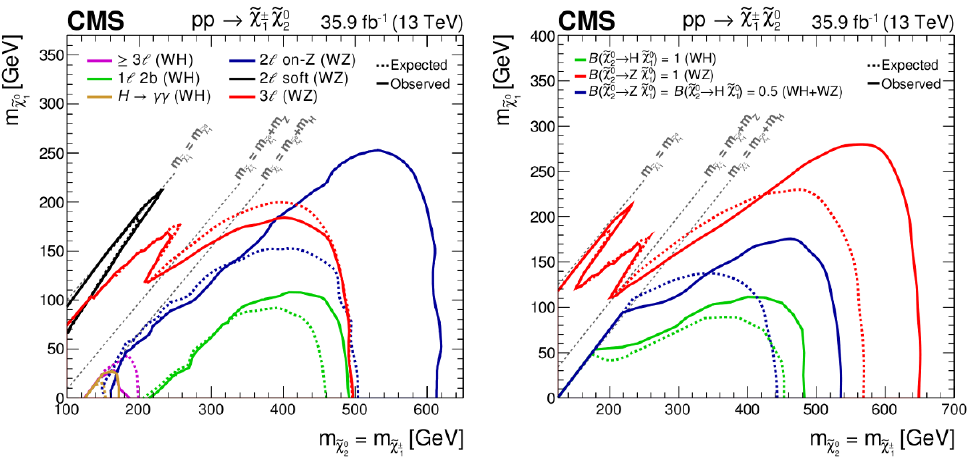
Figure 10 . Exclusion contours at 95% CL in the plane of m production (left) for the individual analyses and (right) for the combination of analyses. The decay modes assumed for each contour are given in the legends.